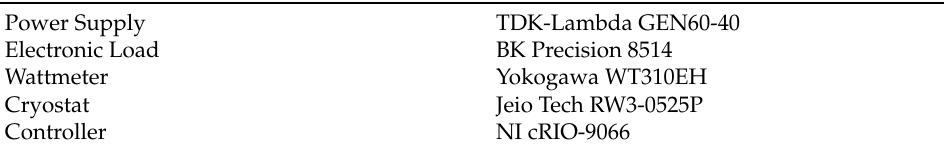
Figure 2. Test bench. Table 1. Test bench equipment specifications.